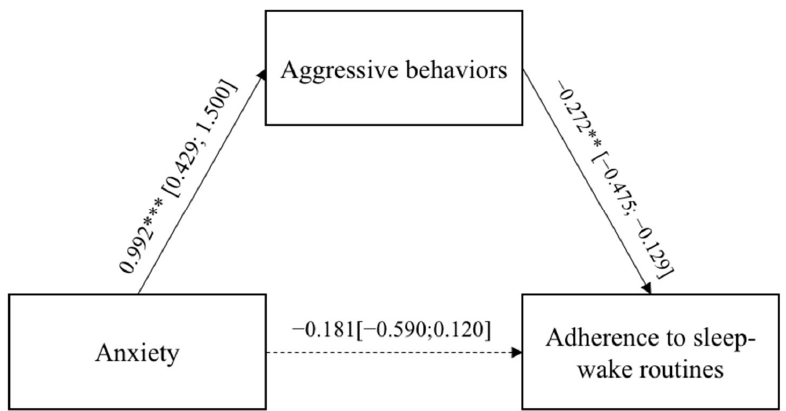
Figure 3. Results of Model 3. The bootstrap intervals of confidence are reported in brackets. * p < 0.05; ** p < 0.01; *** p < 0.001.